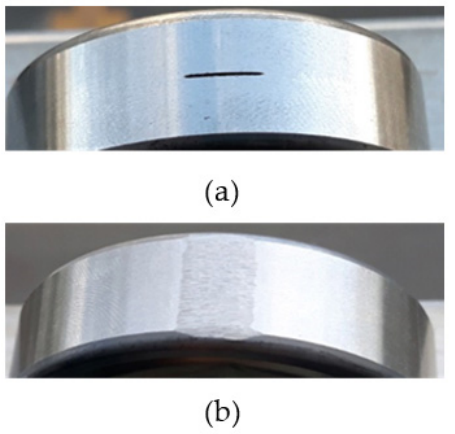
Figure 3. Basic scratch faults: ( a ) single scratch (SS) and ( b ) full scratch (FS). Additionally, faults with multiple concentrated scratches (CS) were considered. Par- allel scratches were generated on the outer raceway. Each scratch had a length of 10 mm, width of 0.5 mm, and depth of 0.5 mm. The concentrated scratches with two parallel scratches were indicated as C2S and four parallel scratches as C4S. The dimensions were stated for C2S as two parallel scratches 0.5 mm apart and, for C4S, as four parallel scratches 0.5 mm apart on the outer raceway of the